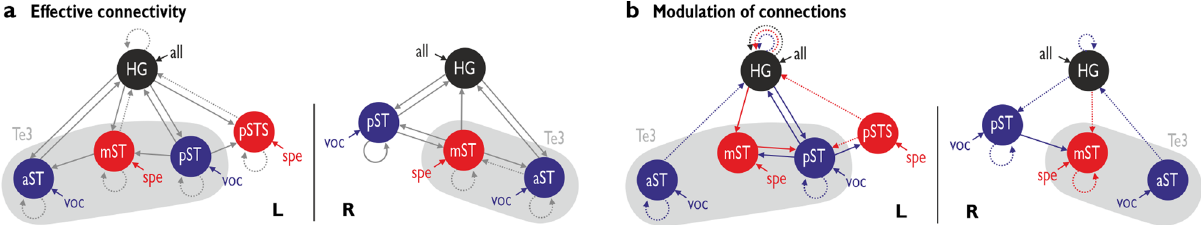
Fig. 3 DCM effective neural network modeling. Signi fi cant network effects (posterior probability > 0.99) in bilateral AC after a parametric empirical Bayes (PEB)-based model reduction from the full model; sample of n = 52 human participants. a Neural networks based on the effective connectivity parameters and b modulation of connections. Bold lines for positive effects, dotted lines for negative effects. Gray shading indicates the auditory area